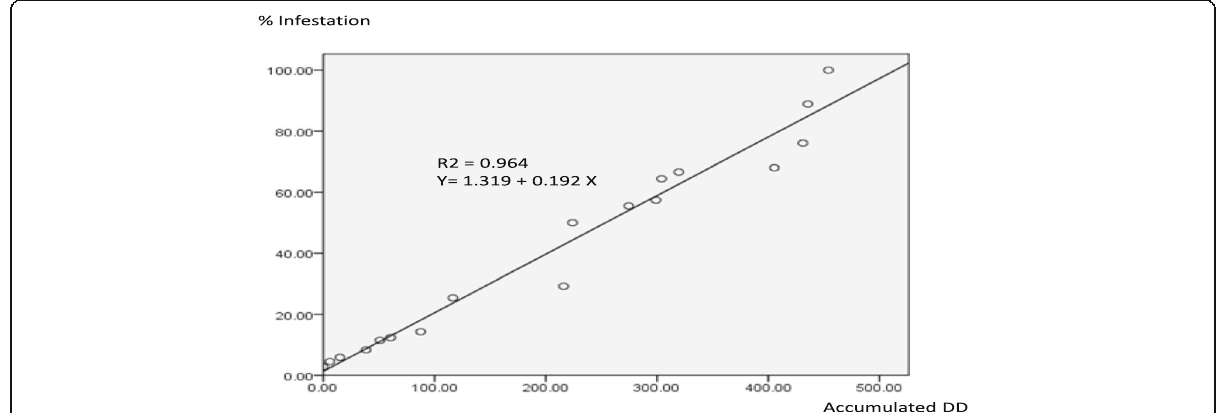
Fig. 3 Regression line of accumulated degree-days and percentages of infested Orobanche capsules with P .